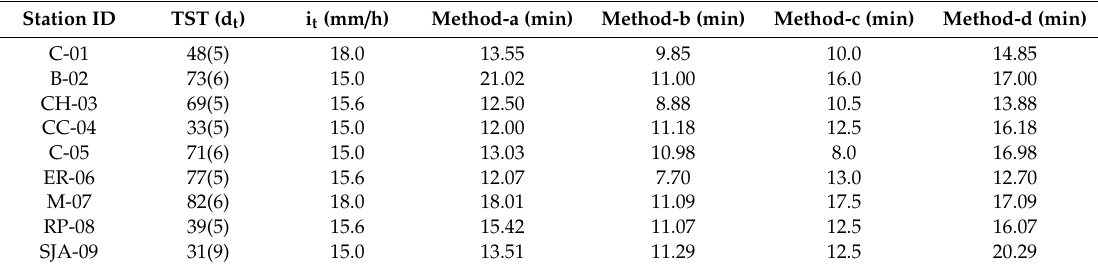
Table 3. Values of coe ffi cient C, for the proposed analysis conditions.